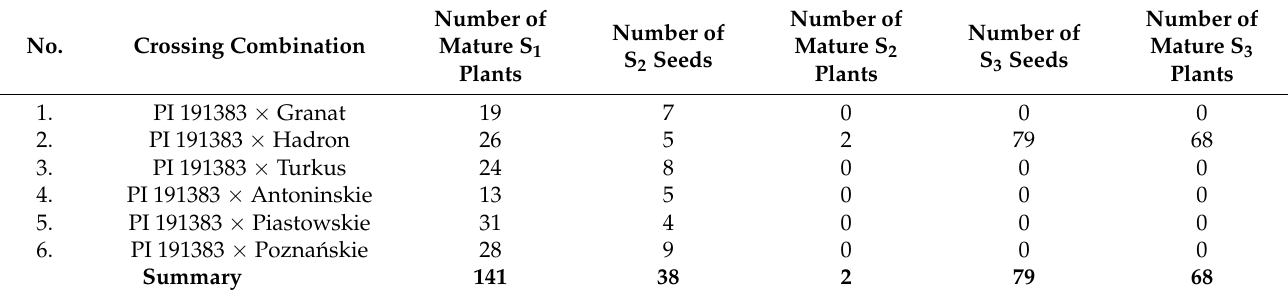
Table 3. Subsequent self-pollinations of A m A m RR amphiploids.